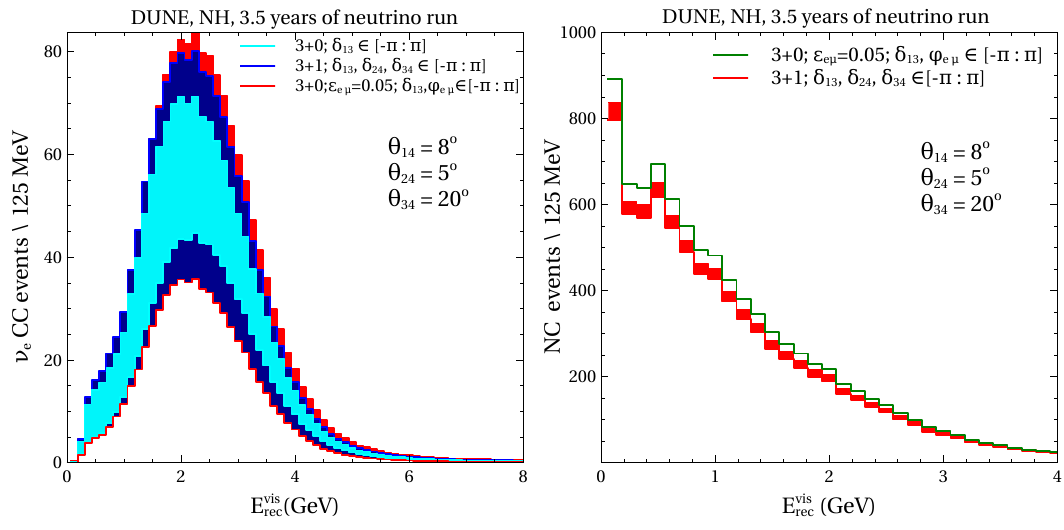
Figure 7 . CC and NC events as a function of reconstructed neutrino energy in DUNE with 3.5 yrs of neutrino running. The left panel corresponds to (cid:23) e CC events for two di(cid:11)erent new physics scenarios, as well as for the standard 3+0 paradigm. The green line and the red band in the right panel show NC neutrino events in the presence of propagation-related NSI, and in the presence of a sterile neutrino, respectively. In all cases the respective CP phases have been varied over their full range of [ (cid:0) 180 (cid:14) ; +180 (cid:14) ]. In the case of NSIs, A ( (cid:14) e(cid:11) (cid:14) e(cid:12) + (cid:15) (cid:11)(cid:12) e i(cid:30) (cid:11)(cid:12) ) ( (cid:11); (cid:12) = e; (cid:22); (cid:28) ) represents the matter term in the e(cid:11)ective Hamiltonian in the presence of NSIs. Here, A is the Wolfenstein matter term and is given by A (eV 2 ) = 0 : 76 (cid:2) 10 (cid:0) 4 (cid:26) (g = cc)E(GeV), (cid:26) being the matter density and E , the neutrino energy. The chosen example values of NSI and sterile parameters are shown in the key. The remaining NSI parameters are equal to